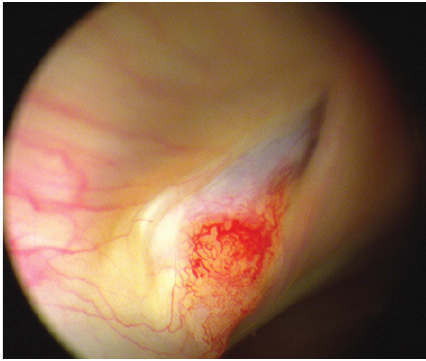
Figure 4: 3D reconstruction of pelvis depicting the right pubic ramus injury from the RTA 5 years prior.